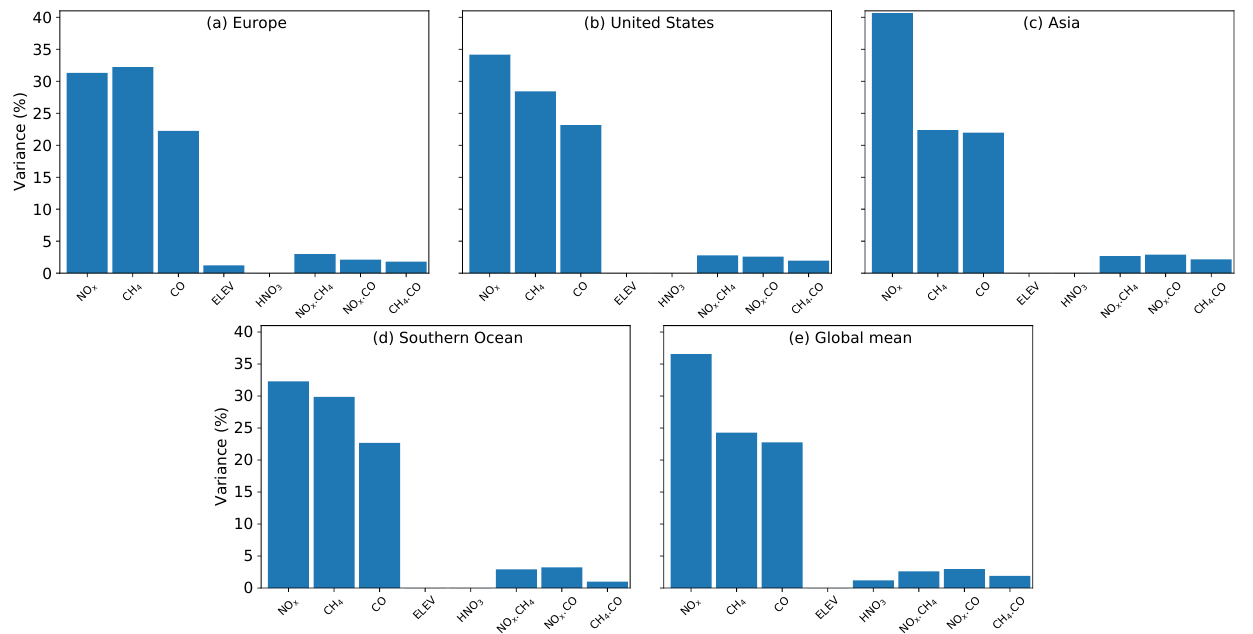
Figure 5. Contributions to variance from the sensitivity forcings/parametrizations applied (Table 1), for the same regions shown in Fig. 3. For clarity only those which contribute at least 1% to the variance are shown. NO x is the NO x emissions; CH 4 is the CH 4 concentrations; CO is the CO + NMVOC emissions; ELEV is the number of vertical model levels that NO x , CO and NMVOC emissions are prescribed on. HNO 3 is the rate of HNO 3 washout. Joint interactions, indicated by, e.g. NO x . CH 4 concentrations are also indicated where these contribute at least 1% to the